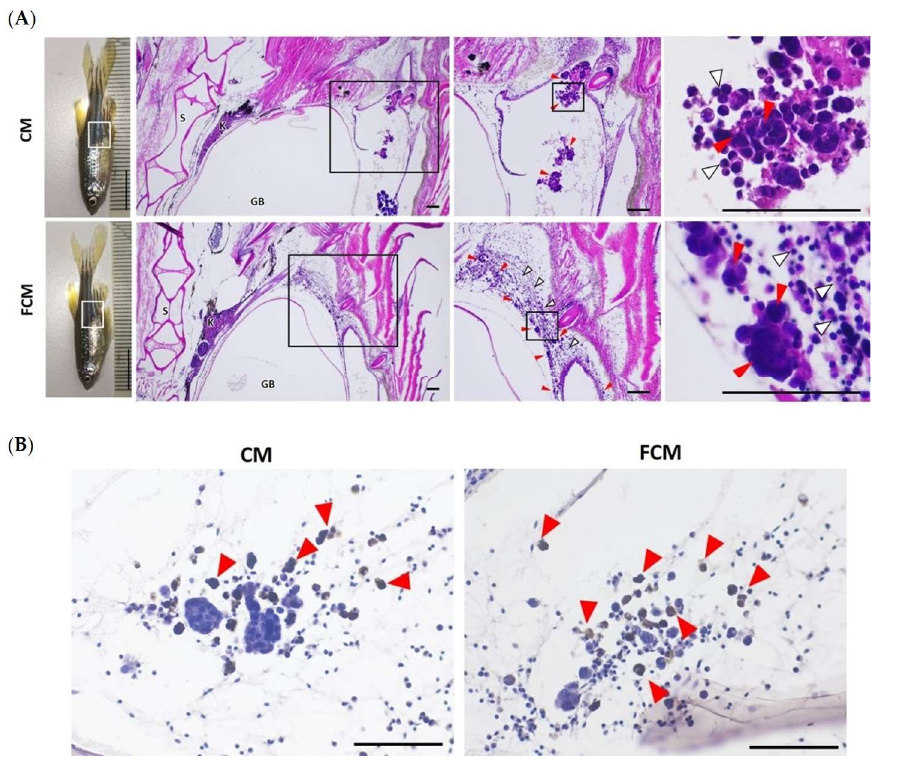
Figure 6. TrxR-1 positive on FCM induced disseminating HCT116 in zebrafish model. ( A ) Pathohis- tological analysis indicates the microtumors and scattered cancer cells (red arrow) surrounded by leukocytes (white arrow). Magnification 40 × , 100 × , and 400 × , respectively. S = spine, K = kidney, GB = gas bladder, CM = complete media (control), and FCM = fibroblast-cultured media. ( B ) Im- munohistochemical analysis represents the positive TrxR-1 (brown color) in the spreading cells (Magnification 400 × ). CM = complete media (control), and FCM = fibroblast-cultured